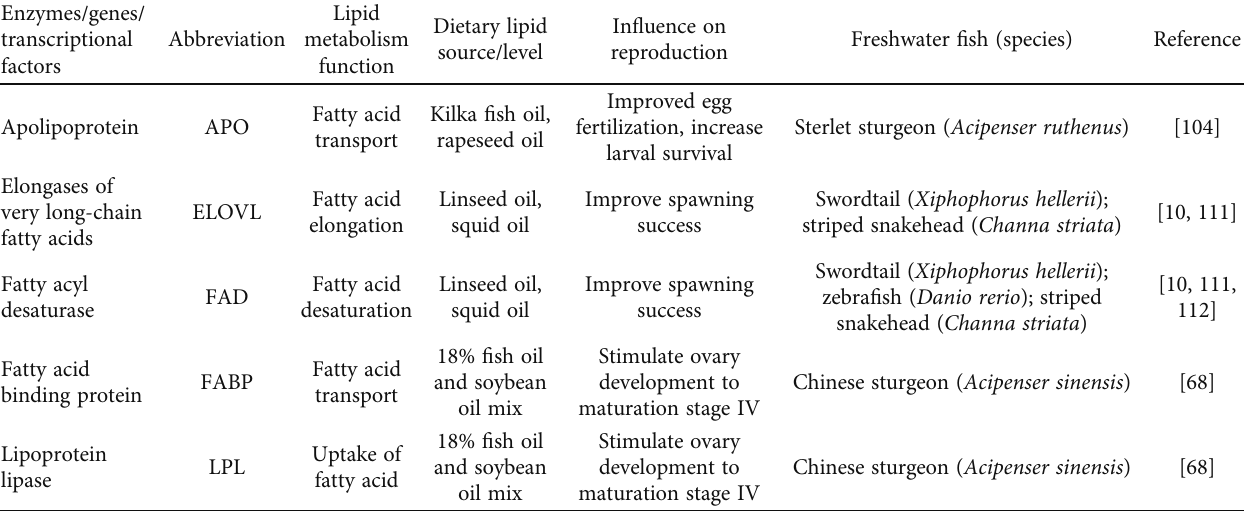
Table 2: Summary of lipid metabolism-related genes modulating reproduction in freshwater fi n fi